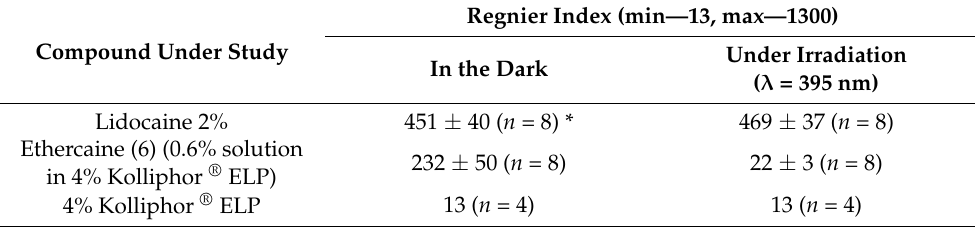
Table 1. Studies of the local anesthetic effect of ethercaine (6) in